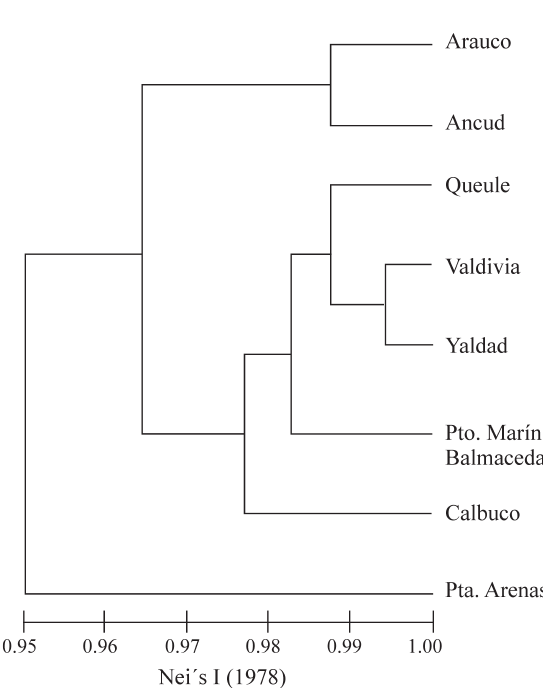
Figure 2 - A phenetic dendrogram showing the relationship of eight popu- lationsofthechileanbluemussel( Mytiluschilensis ),basedonsevenpoly- morphic loci.